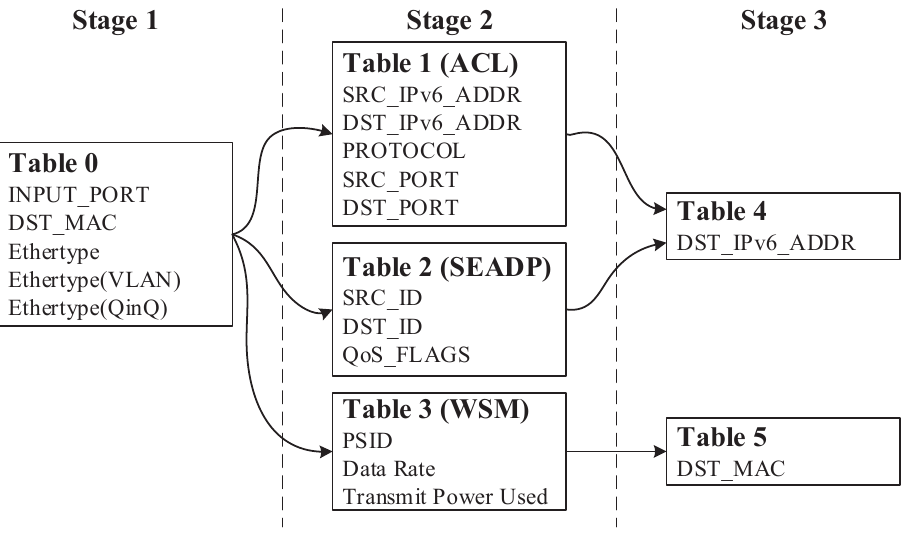
Figure 10. The traffic forwarding